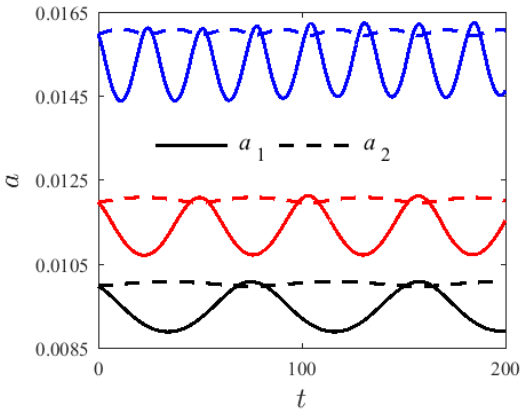
= 0.2 π 0.2 ). Figure 2. Variation modes for different initial conditions a ( γ 0 0